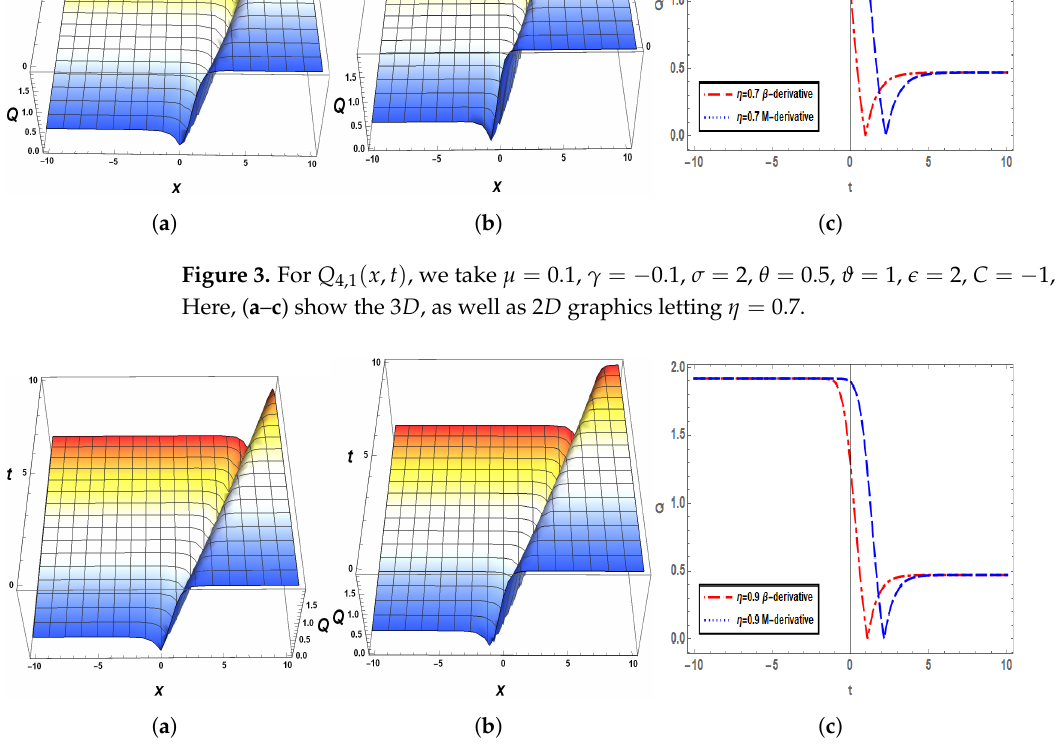
Figure 4. Here, ( a – c ) manifest the 3 D and 2 D plots for Q 4,1 ( x , t ) taking η = 0.9 at t = 1. Figure 6a,b display the 3D combined bright–dark-type soliton propagation at fractional order η = 0.3 with the Beta and M-truncated fractional operator, respectively. Figure